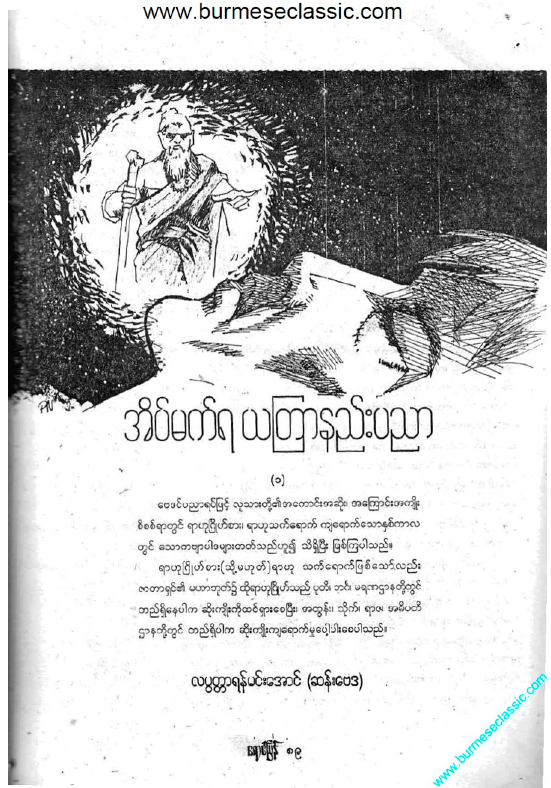
Figure 1. An example of dream accounts published in popular Burmese Buddhist magazines. Notice the counting beads around the necks of the hermits here and in Figure 2. ( Ro ṅ ʻ pran ʻ maggaja ṅ ʻ ʺ , May 2015).